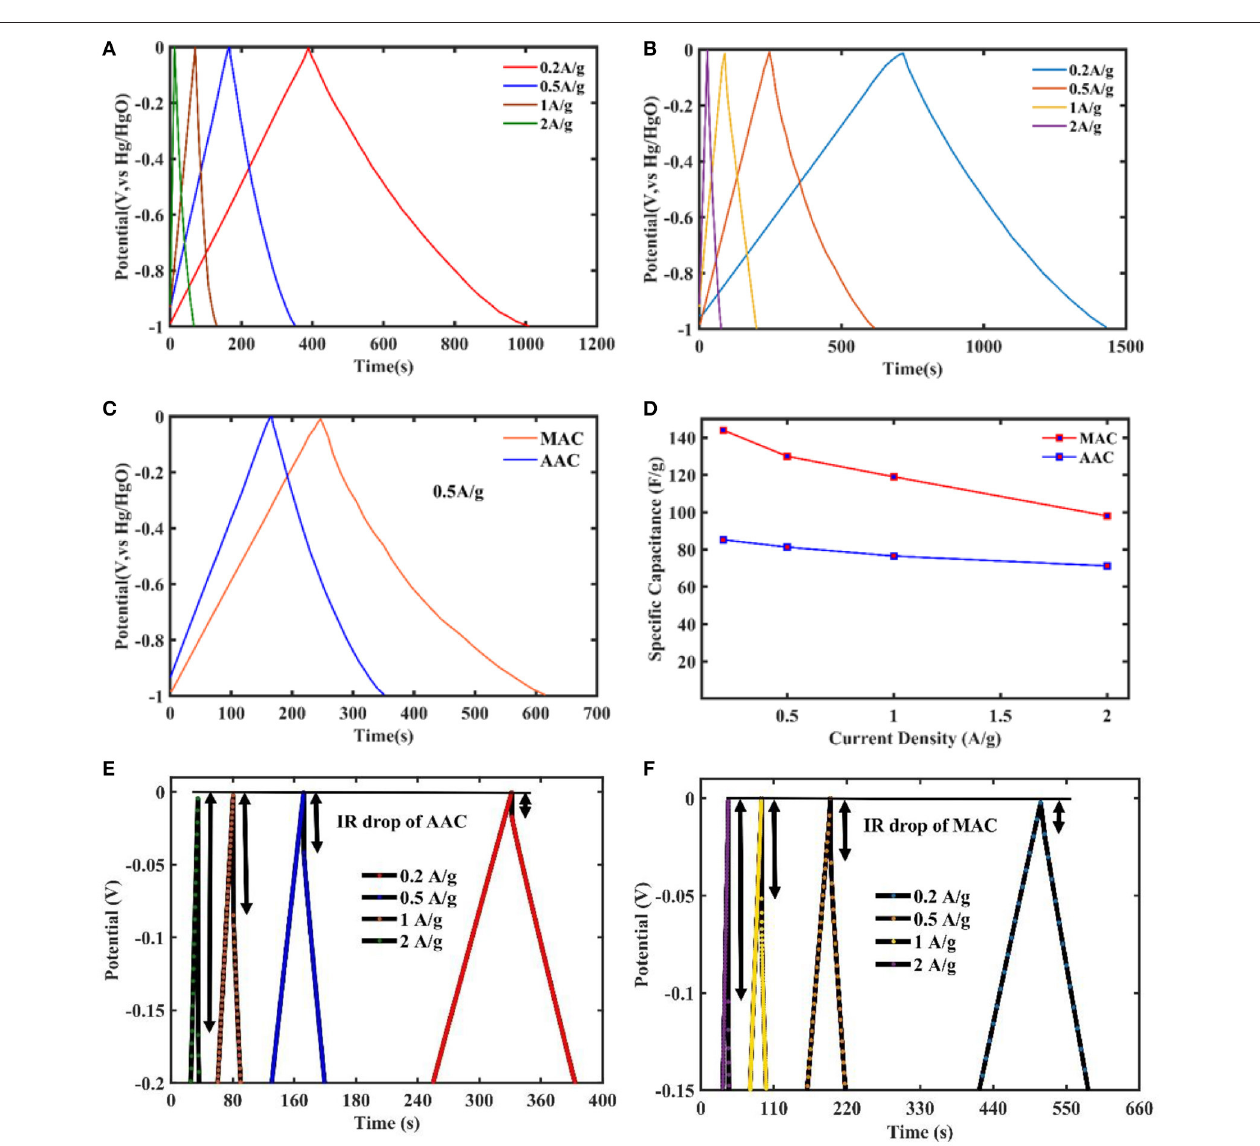
FIGURE 8 | (A) GCD lines of MAC obtained at 0.2, 0.5, 1, and 2 A/g; (B) GCD lines of AAC obtained at 0.2, 0.5, 1, and 2 A/g; (C) GCD lines of MAC and AAC obtained at 0.5 A/g; (D) Specific capacitance of MAC and AAC at different current density; (E) IR drop of AAC; (F) IR drop of MAC.